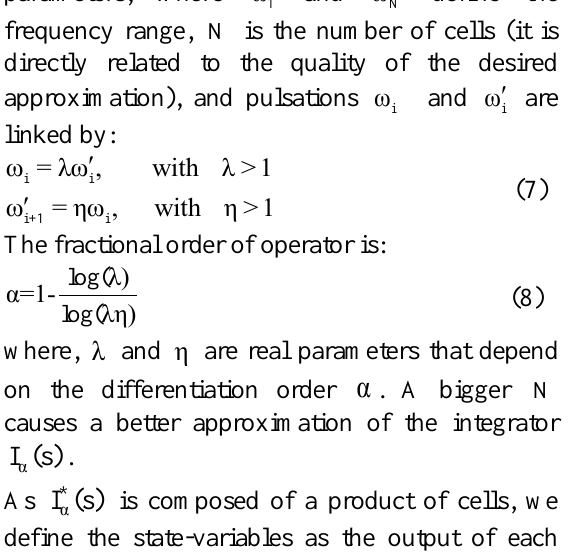
Figure 3. State-space representation of non-linear